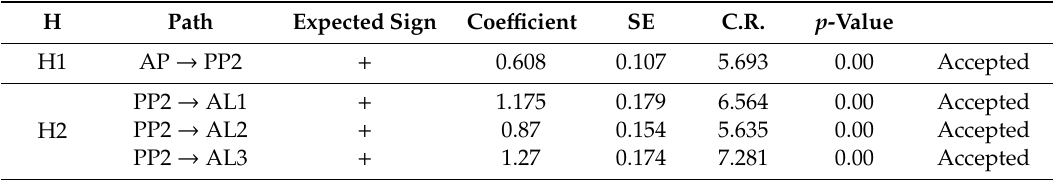
Table 12. Paths through